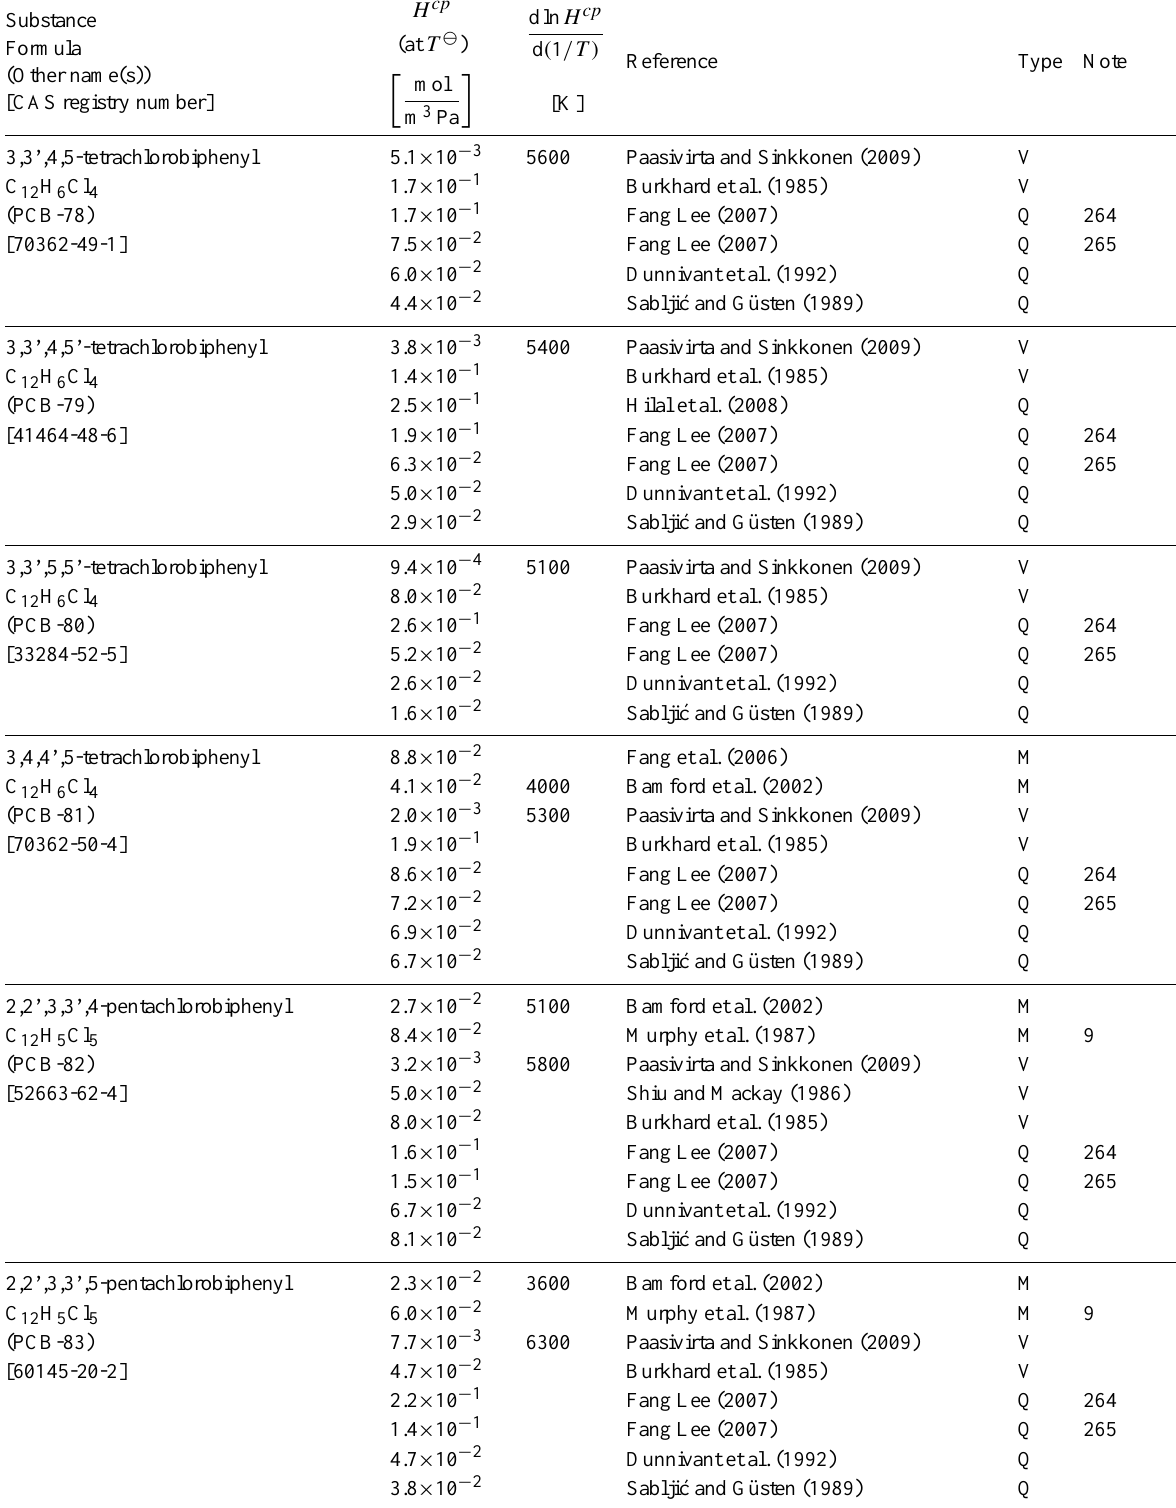
Table 6: Henry’s law constants for water as solvent